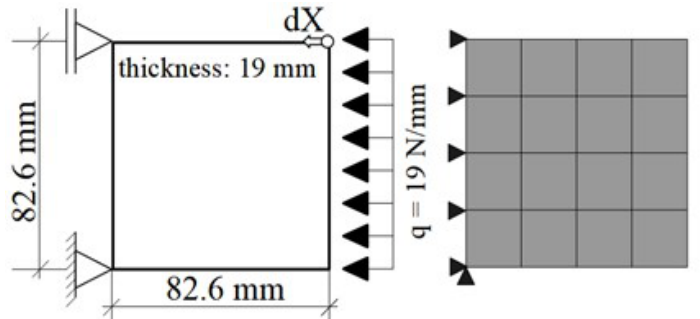
Figure 10. Direct compression simulation - geometry and mesh.